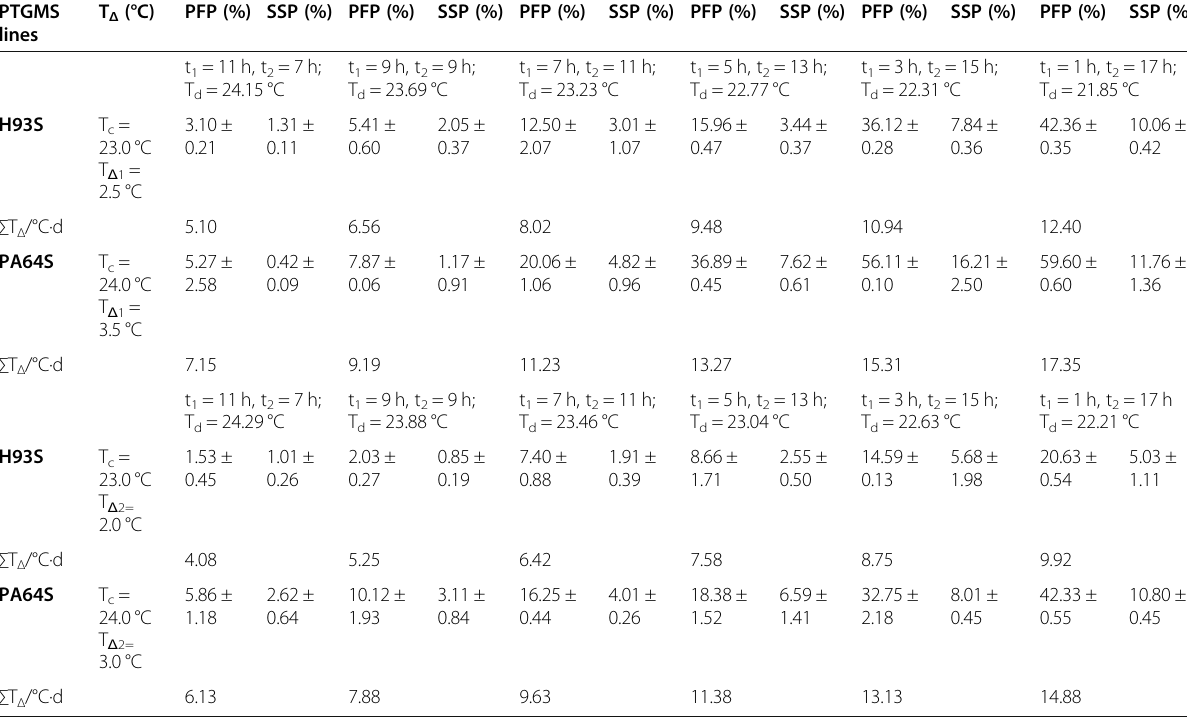
Table 3 The PFPs and SSPs of H93S and PA64S after 7 d of treatment under different Σ T Δ conditions and a 13.5 h photoperiod PTGMS